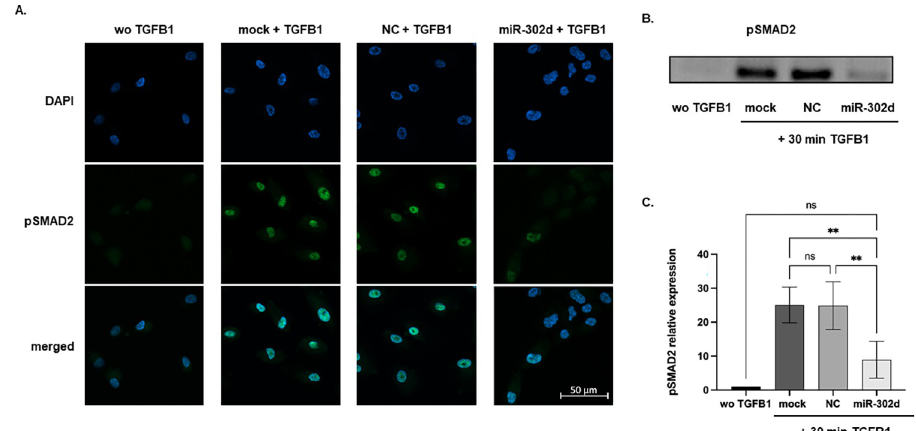
Fig 9. miR-302d suppresses TGFB-induced phosphorylation of SMAD2 in hRPE cells. hRPE cells were treated with or without TGFB1 for 30 min 24 h after transfection with mock, NC, or miR-302d. (A) DAPI (blue) and pSMAD2 (green) staining in hRPE cells. The scale bar represents 50 μ m. (B) Representative Western blot of pSMAD2 30 min after initial TGFB1 exposure. (C) The relative expression of pSMAD2 normalized to total proteins (S1 Raw images). The values were further normalized to the "wo TGFB1" group. One-way ANOVA with Tukey’s multiple comparisons tests (n = 3) were performed. The error bars represent SD. ns, non-significant, �� p < 0.01.